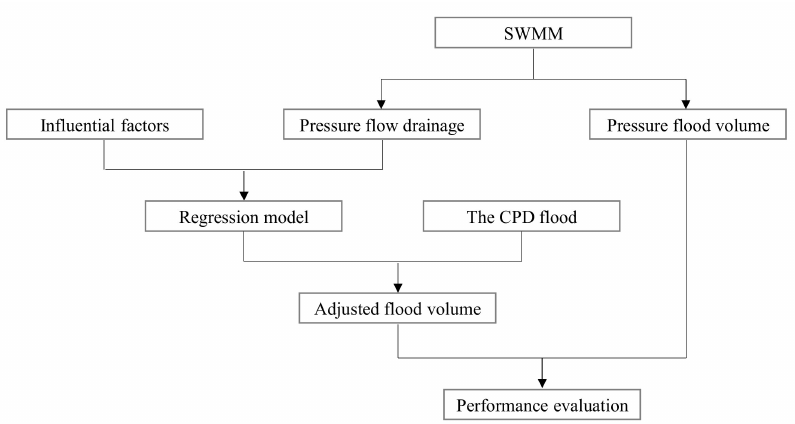
Figure 1. The flowchart to quantify the e ff ect of pressure flow and adjust the flood volumes simulated by the Constant Pipe Drainage